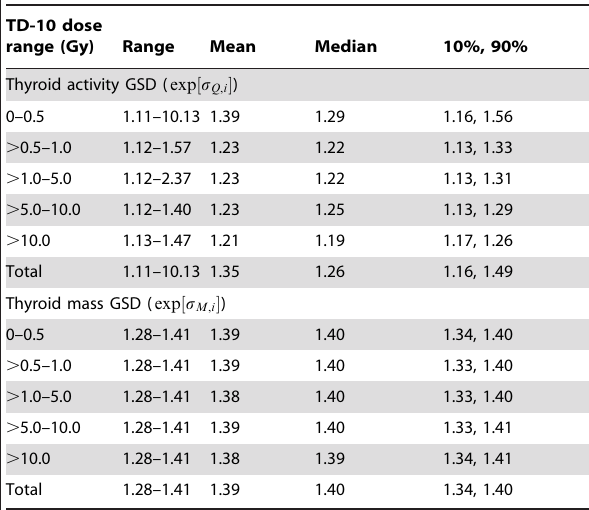
Table 1. Distribution of the geometric standard deviation (GSD) of errors associated with measurements of thyroid activity and of thyroid mass across individuals within the